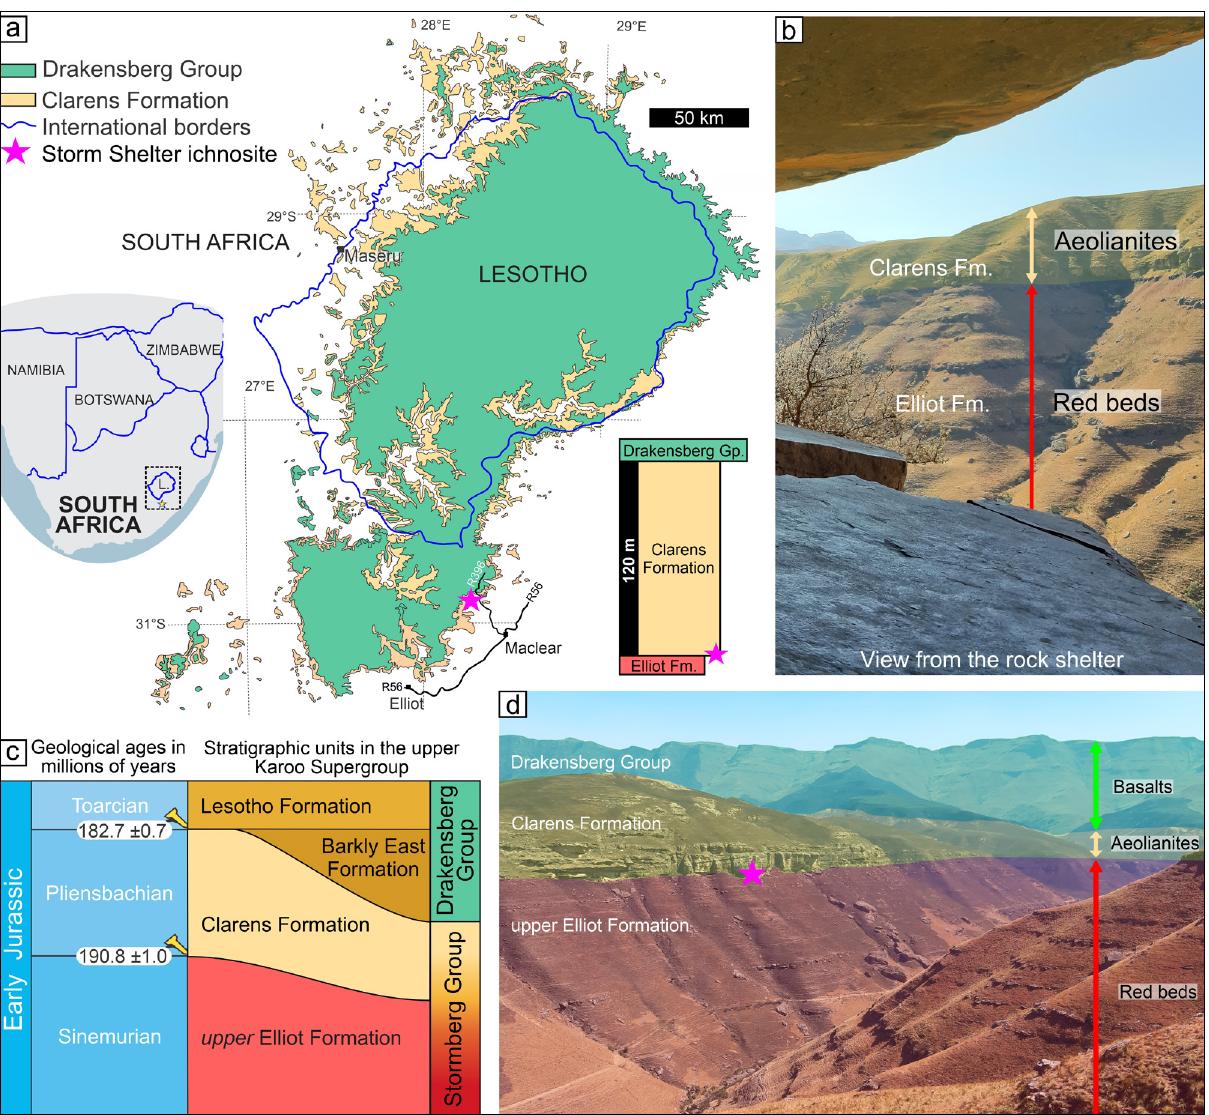
Figure 1: Geological context of the Storm Shelter ichnosite. (a) Simplified geological map of the upper part of the Karoo Supergroup in the Republic of South Africa and Lesotho, showing the position of the study locality northwest of Maclear (Eastern Cape). Inset log shows the local thickness of the Clarens Formation and the relative position of the ichnosite within it. (b–d) Stratigraphic details of the ichnosite within the upper Karoo Supergroup. Map derived by combining data from Johnson and Wolmarans 12 and own